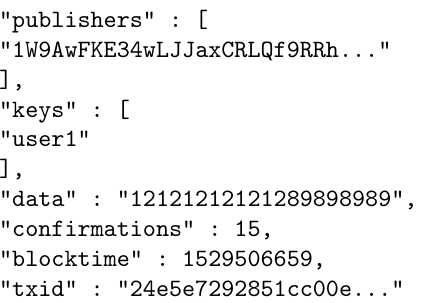
Figure 5. Example of a stream item associated with “user1”.